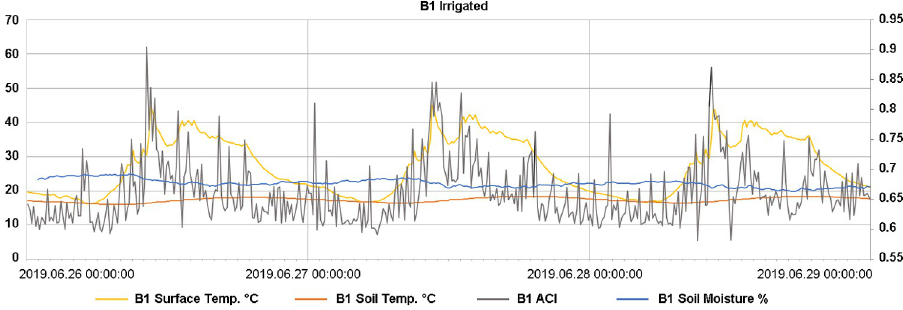
Fig 4. Example of diurnal dynamics in microclimatic parameters and ACI during three days (26.06.2019– 28.06.2019) for sensor B1. Temperature and soil moisture are represented on the left axis, whereas ACI is represented on the right axis. Soil temperature and moisture were measured at 10 cm depth. These three days show a general pattern that may also be found in other periods (S12 Fig).